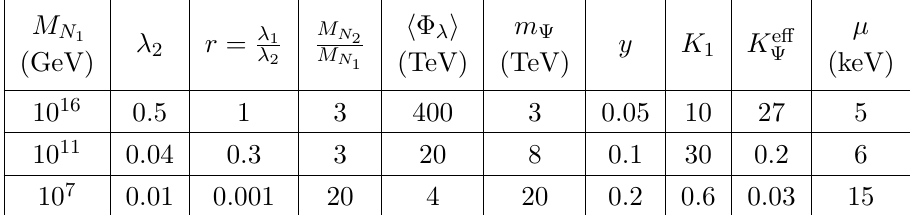
Table 5 . Three di(cid:11)erent benchmark points consistent with neutrino mass data and leptogenesis, organized by Majorana singlet mass